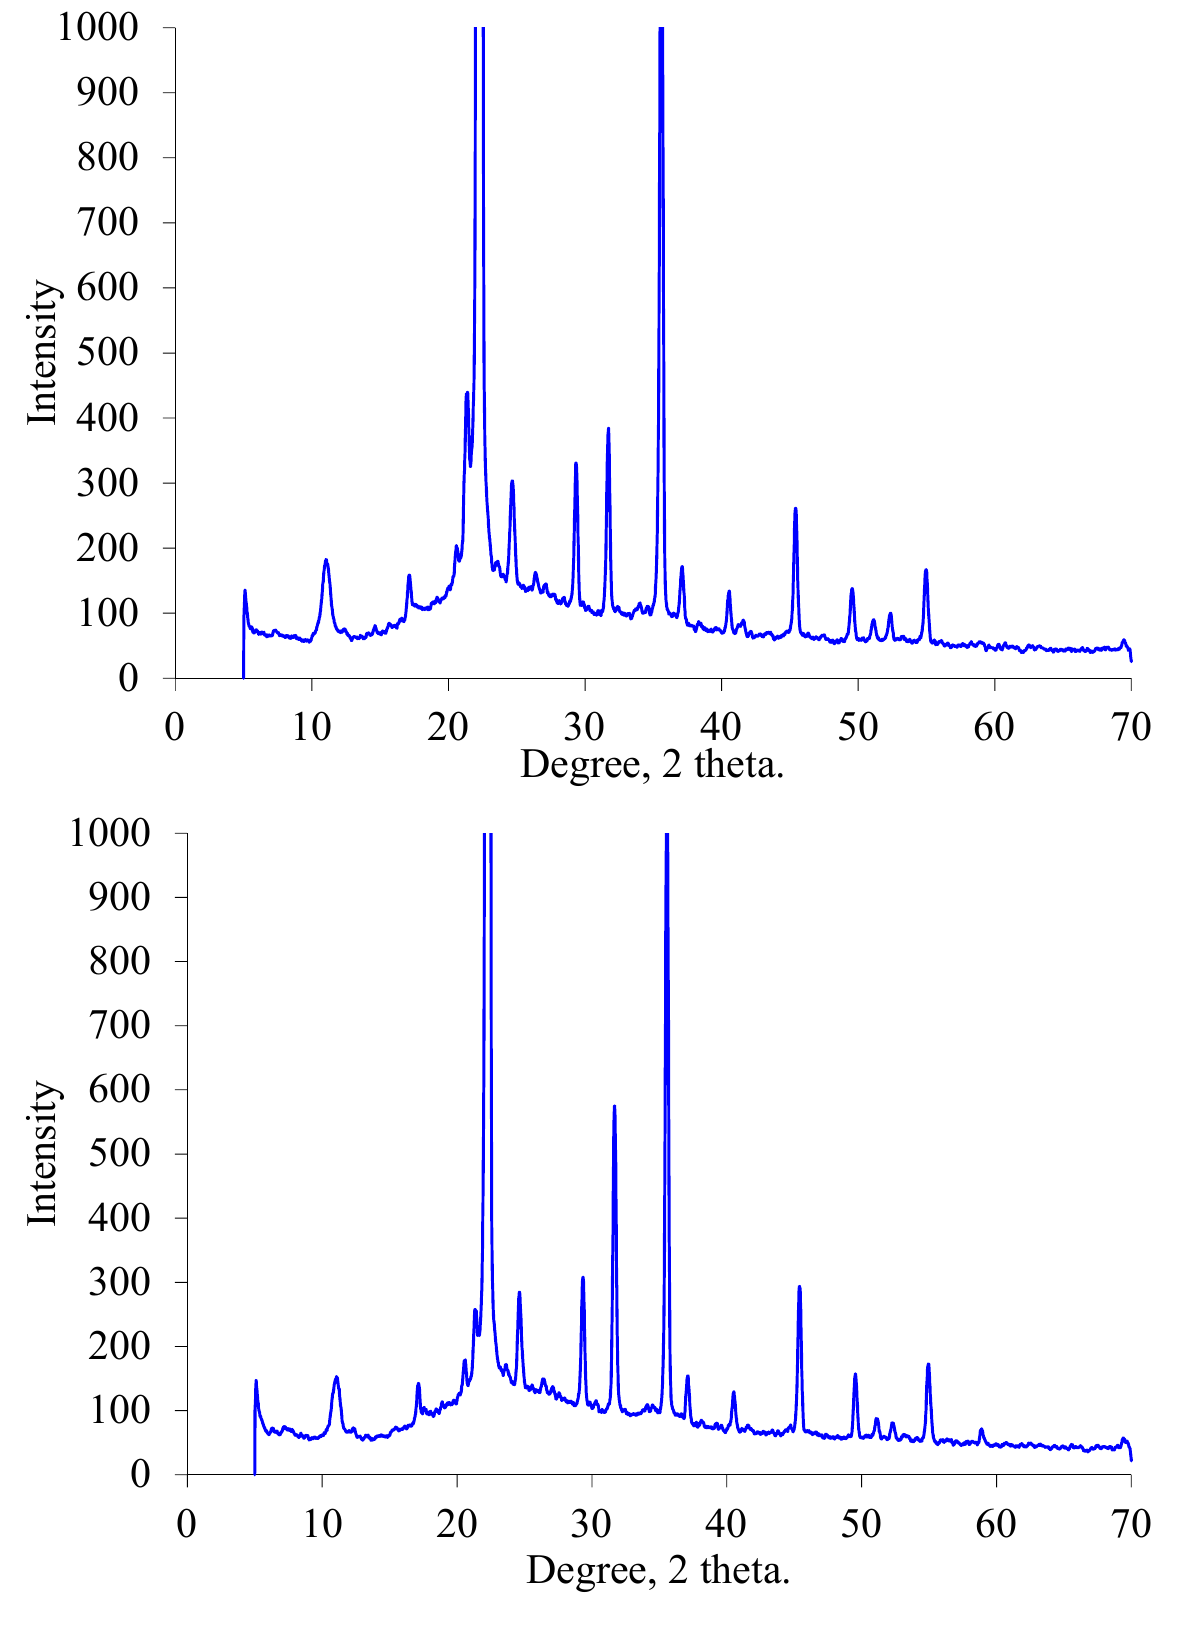
Figure 2. XRD patterns for the ammonium sulfamate–urea system with different component ratios heated for different times.